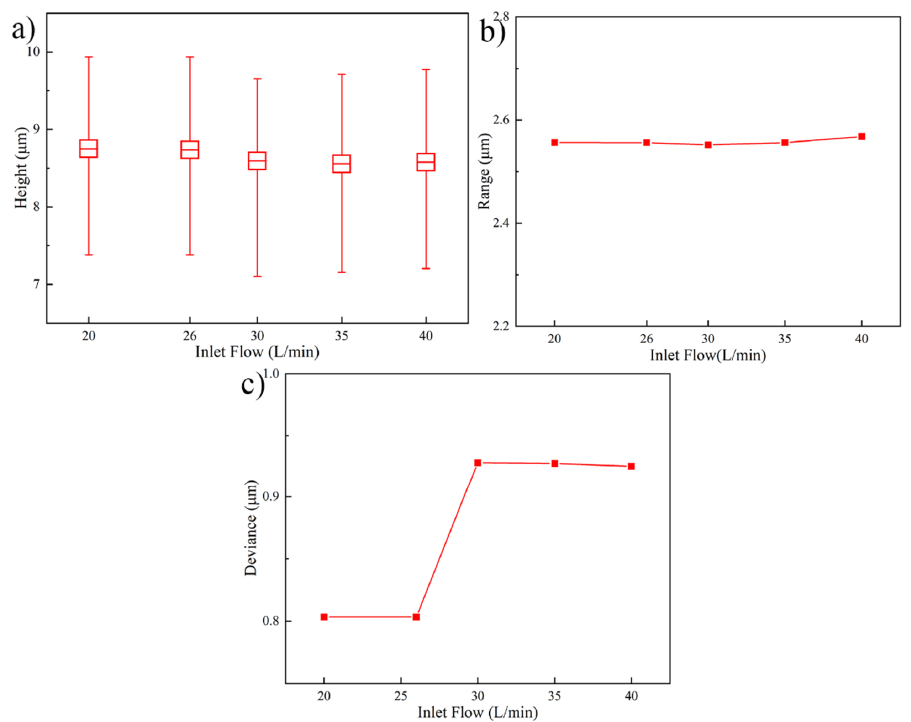
Figure 7. Au bump height and uniformity under different inlet flows. ( a ) Au bump height, ( b ) Au bump range, and ( c ) Au bump deviance. bump range, and ( c ) Au bump